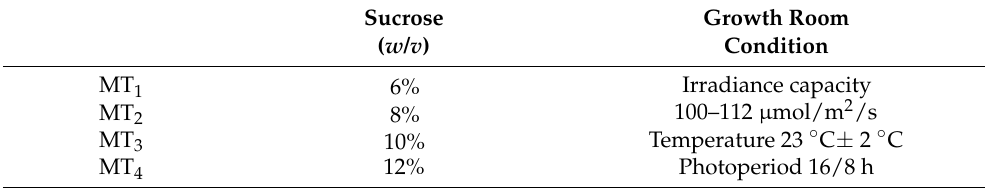
Table 5. MS culture media composition for PFP in vitro microtuberization